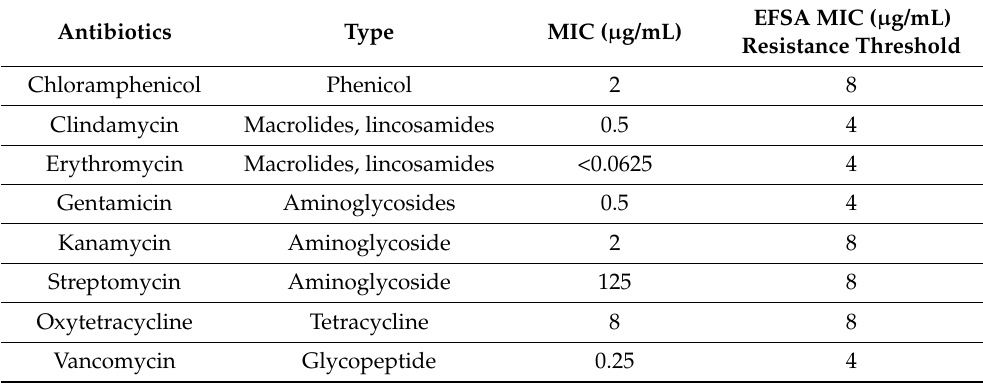
Table 6. In vitro minimum inhibitory concentrations of antibiotics for BS50. The last column